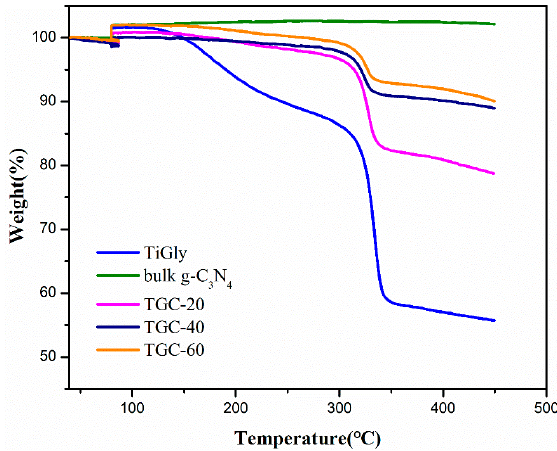
Figure 2. TG profiles of bulk g-C 3 N 4 , TiGly and TGC- x.